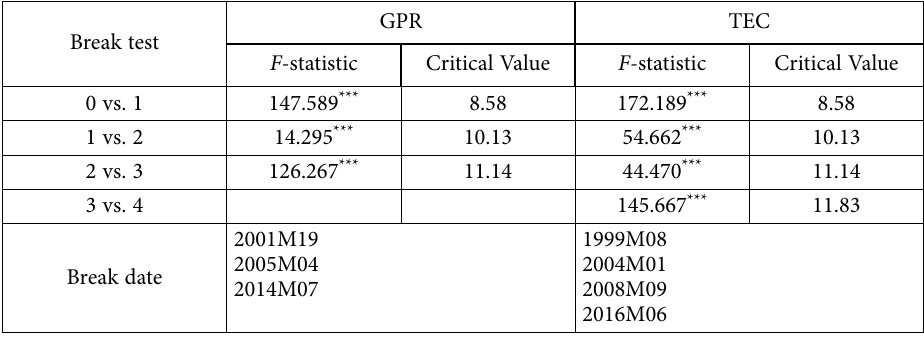
Note : *** denotes significance at the 1%